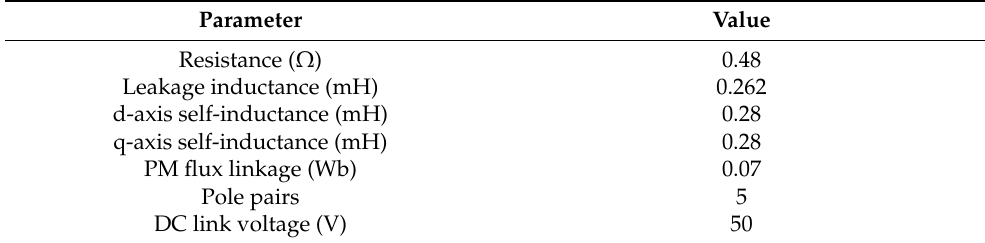
Table 1. Parameters of dual three-phase PM